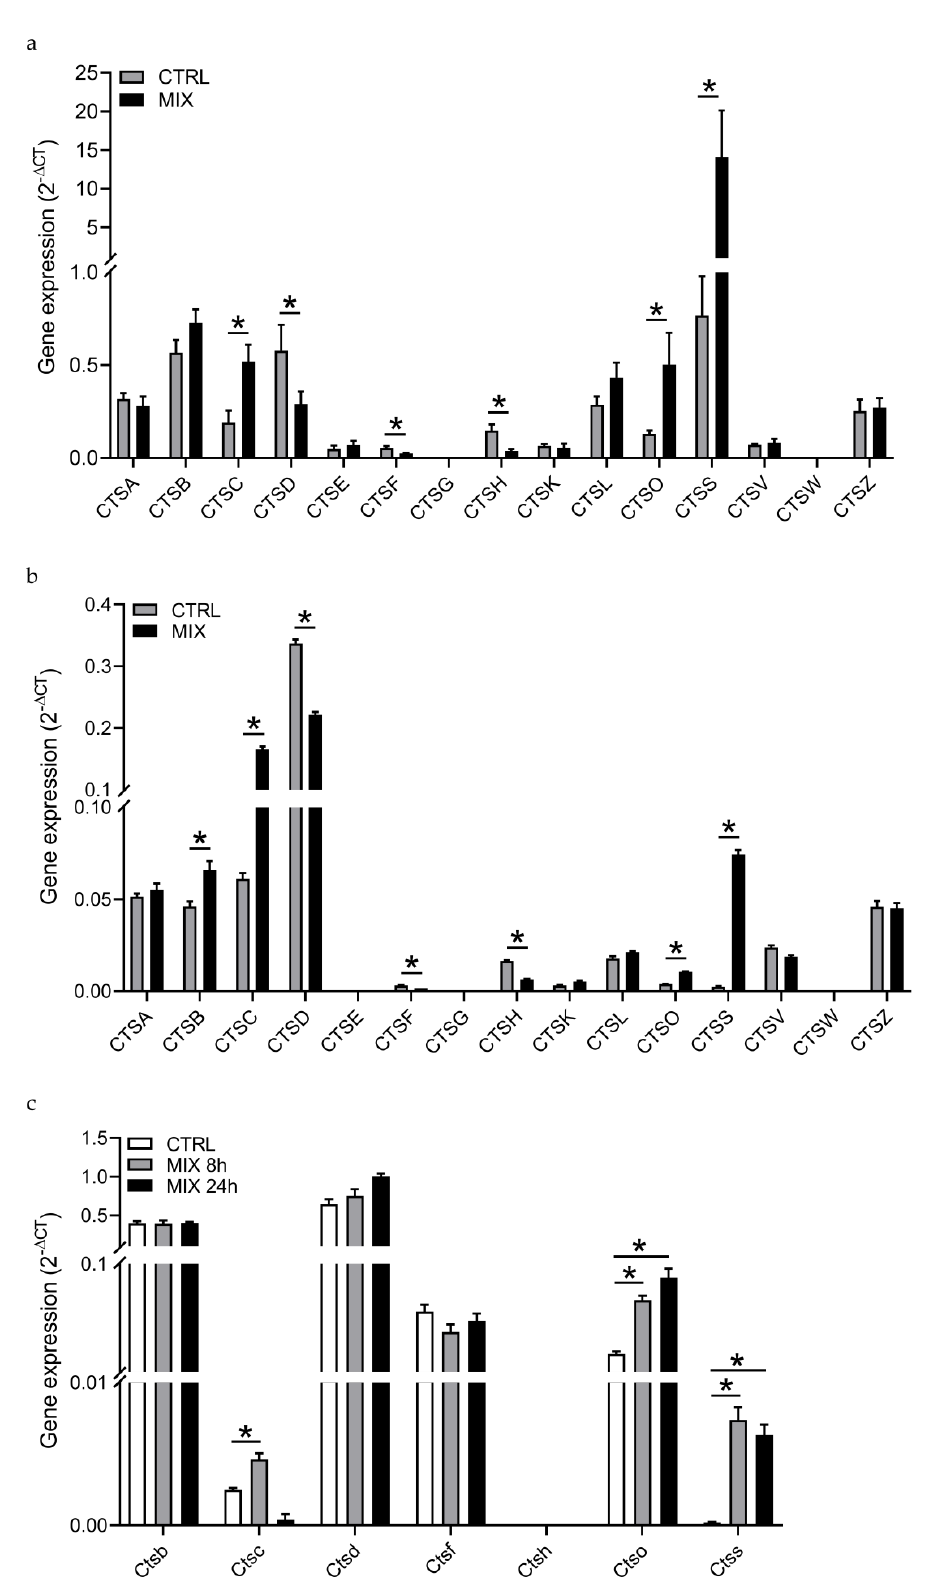
Figure 1. Cathepsin expression and regulation by pro-inflammatory cytokines in human pancreatic islets and β -cell models. ( a ) Gene expression of the 15 cathepsins in isolated human pancreatic islets left untreated (CTRL) or stimulated with IL-1 β and IFN- γ for 24 h (MIX) as measured by real-time qPCR. The data were normalized to the geometric mean of the